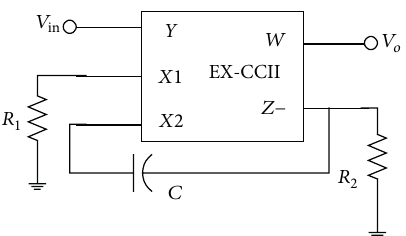
Figure 3: New proposed all-pass filter